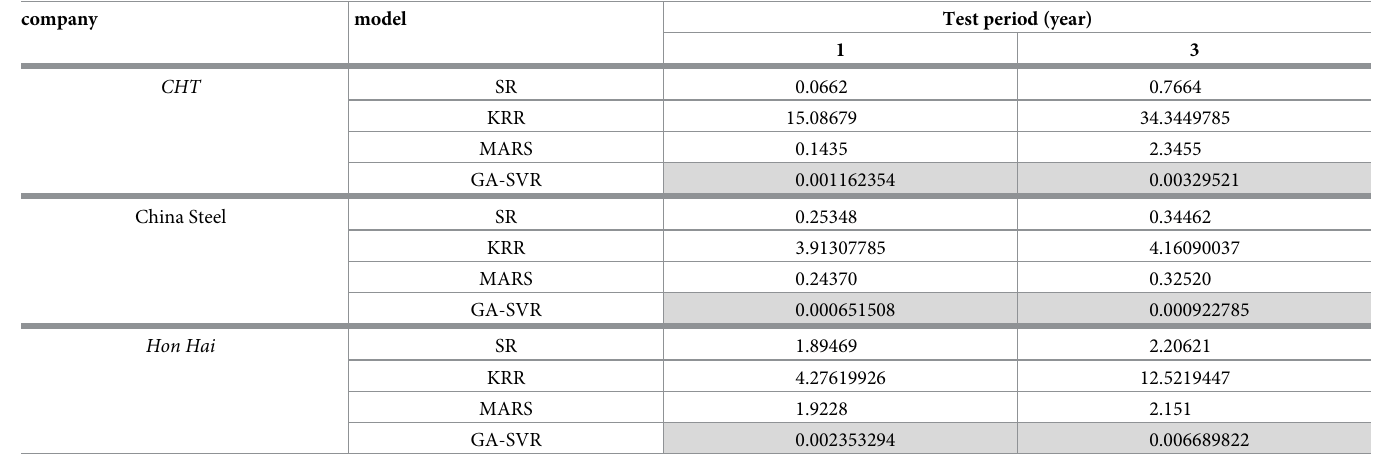
Table 5. The initial performance comparisons for three companies in